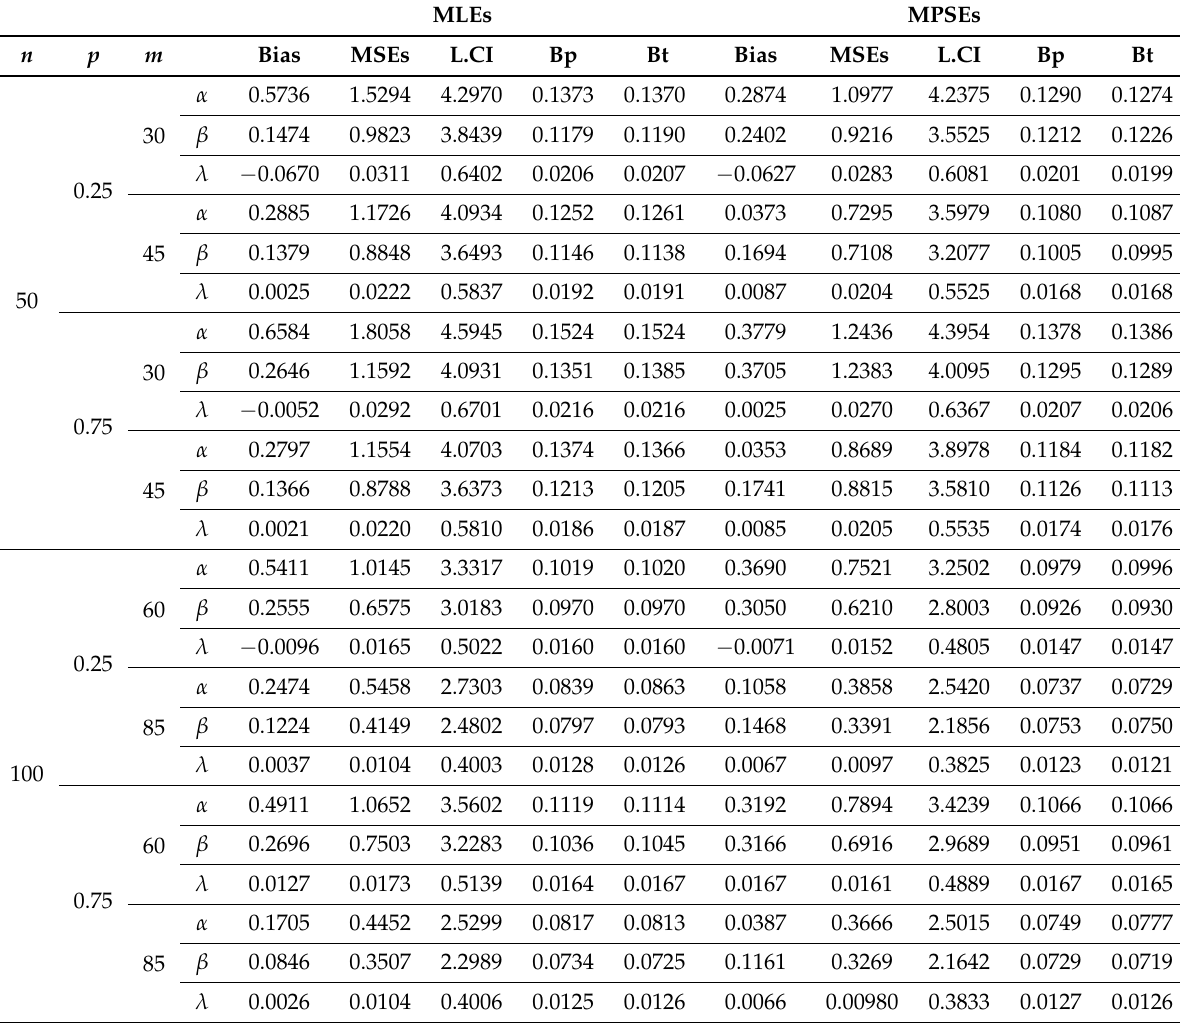
Table 3. The MLEs and MPSEs of the EOWE parameters under progressive type-II censoring scheme with binomial removals for Case